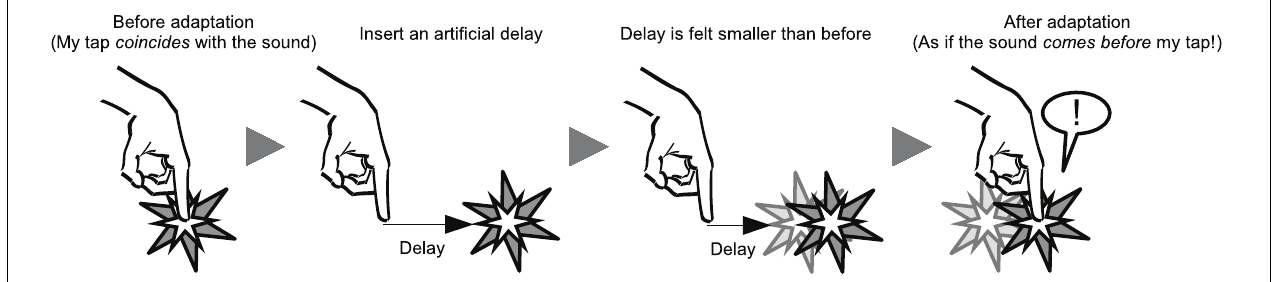
FIGURE 1 | Schematic illustration of the temporal recalibration (TR) and degraded sense of agency (SoA) after the TR. After exposure to an artificial delay between a voluntary action (i.e., a tap) and a subsequent external sensory feedback (i.e., a sound), a perception of subjective simultaneity between the action and the feedback is modulated drastically in a way that an objectively synchronous sensory feedback is perceived as if it comes before the action.